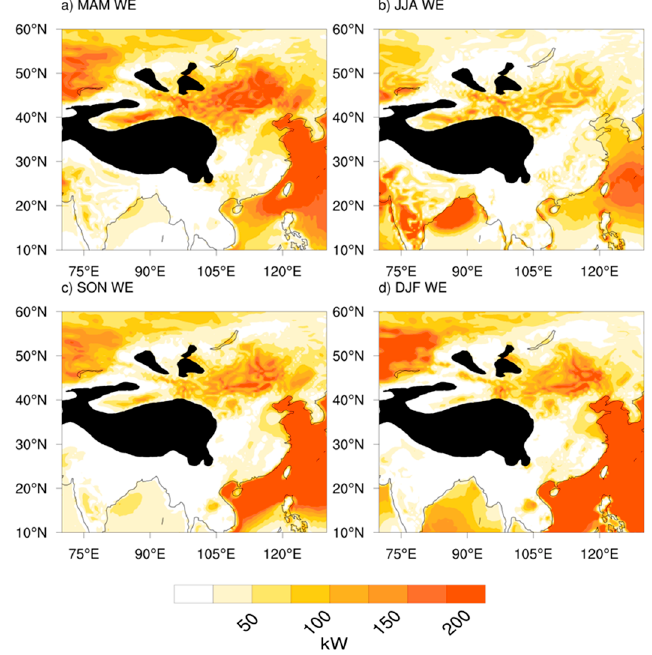
Figure 4. Average wind energy (in kW) between 1979 and 2014 ( a ) spring MAM, ( b ) summer JJA, ( c ) autumn SON, and ( d ) winter DJF.